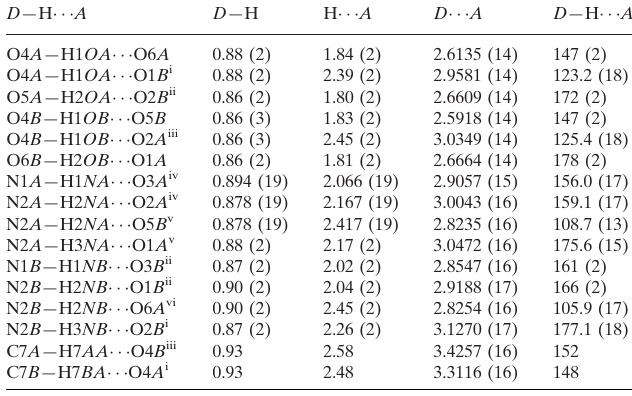
Hydrogen-bond geometry (A˚ , (cid:4)